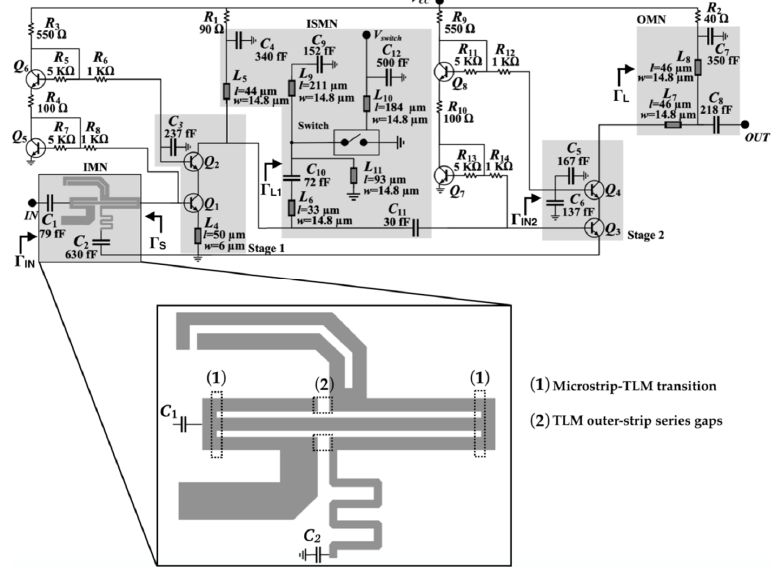
Figure 1. Schematic of the switchable BiCMOS low-noise amplifier (LNA) at 120/140 GHz and a detail of the multimodal three-line-microstrip (TLM) structure implemented in the input matching networks (IMN).